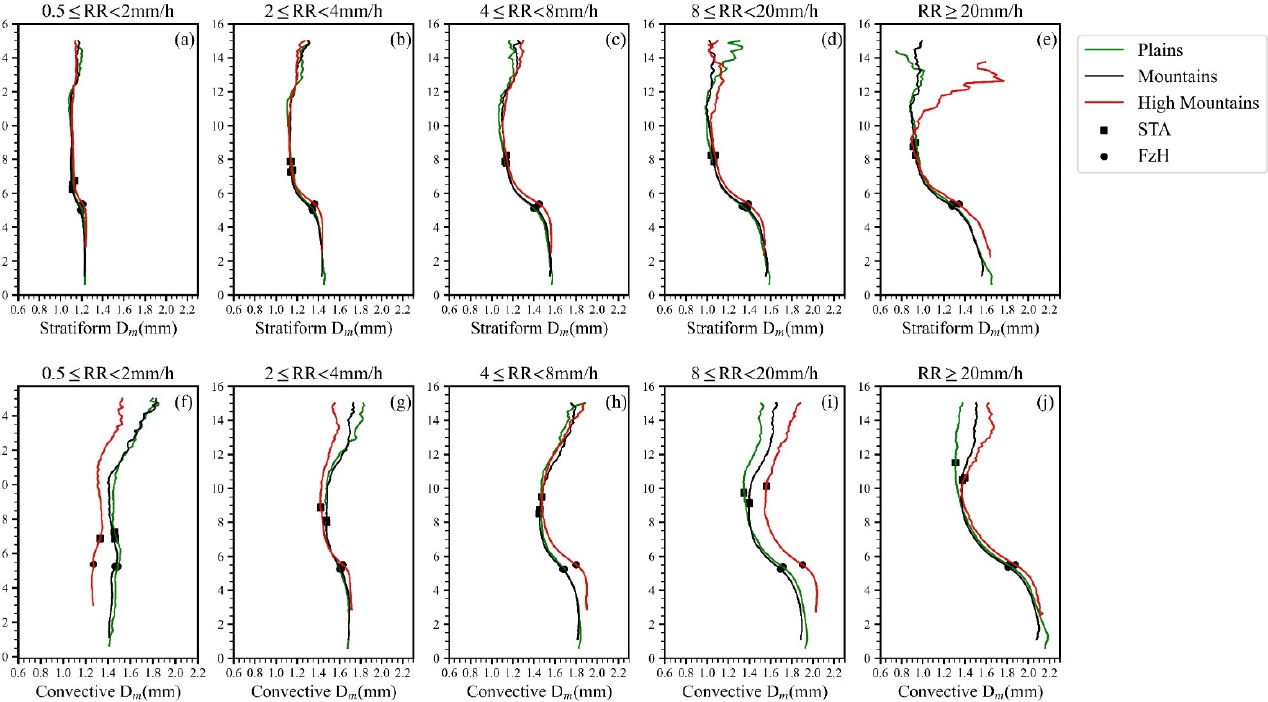
Figure 7. The vertical profile of the mean D m with various near-surface RR. ( a – e ) represent CP, ( f – j ) represent SP. The green, black and red solid lines represent plains, mountains and high mountains, respectively. The square and round dots represent STA and FzH, respectively.